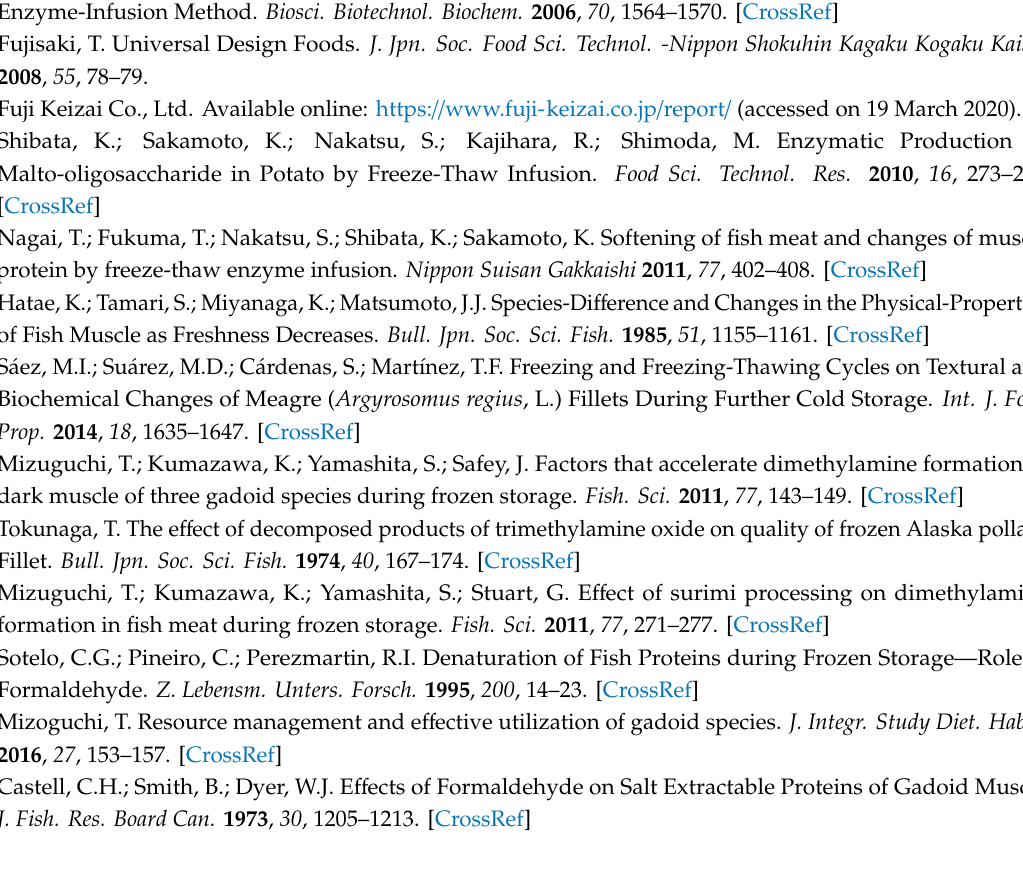
Figure S1: Sample conditions and mass spectra. Figure S2: Mass spectrum of autolysis peptides of